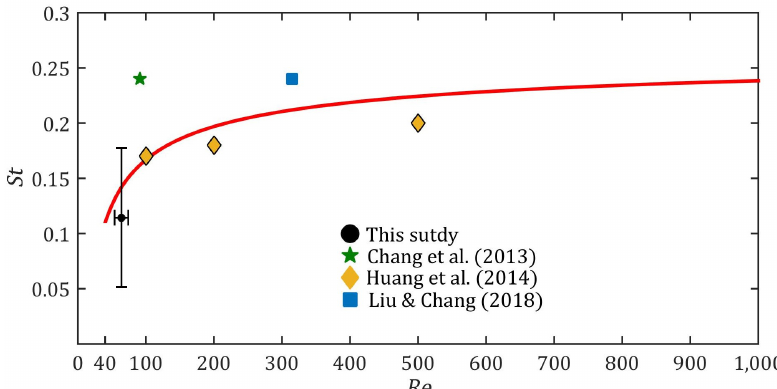
Figure 11. The Strouhal number ( St ) versus the Reynolds number ( Re ) diagram. The point for this study is expressed as the mean value with one standard deviation.